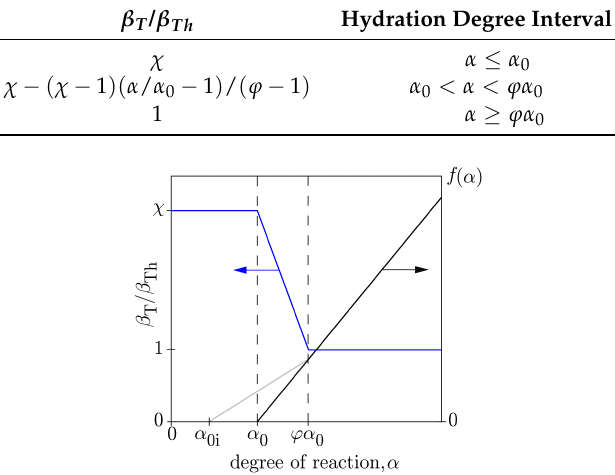
Figure 2. Assumed relationship between coefficient of thermal expansion and degree of cementitious materials